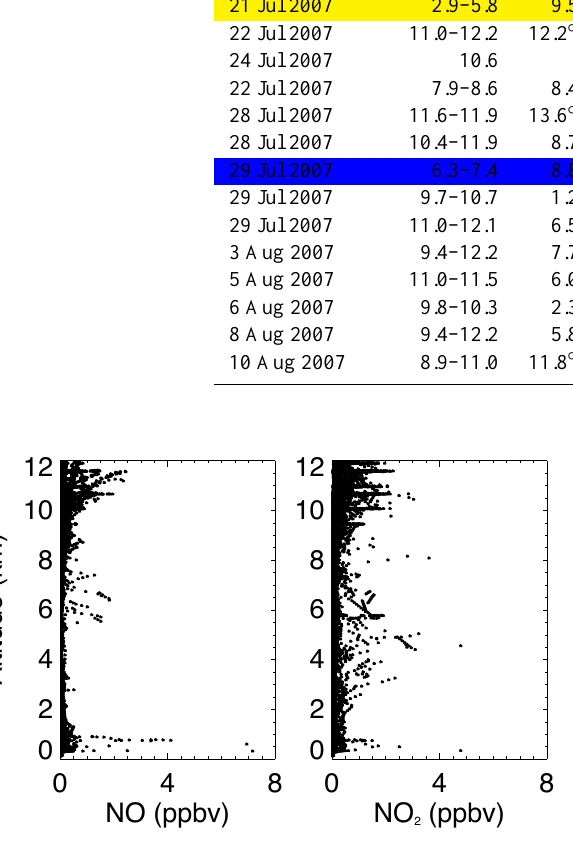
Fig. 13. NO and NO 2 measurements aboard the DC-8 aircraft dur- Figure 13. NO and NO 2 measurements aboard the DC-8 aircraft during TC4. All measure-3 ing TC4. All measurements taken at least 10min after take-off and ments taken at least 10 minutes after take-off and 10 minutes before landing at a distance of 4 10min before landing at a distance of > 50km from the airport in > 50 km from the airport in Alajuela, Costa Rica airport (10.0 0 N, 84.2 0 W) are shown. 5 Alajuela, Costa Rica airport (10.0 ◦ N, 84.2 ◦ W) are shown.